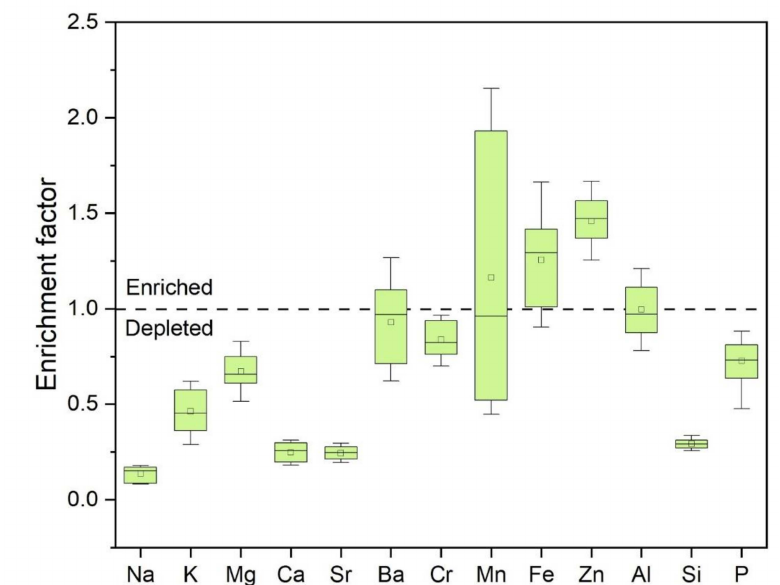
Figure 8. Enrichment factor of analyzed elements from the soil profile.